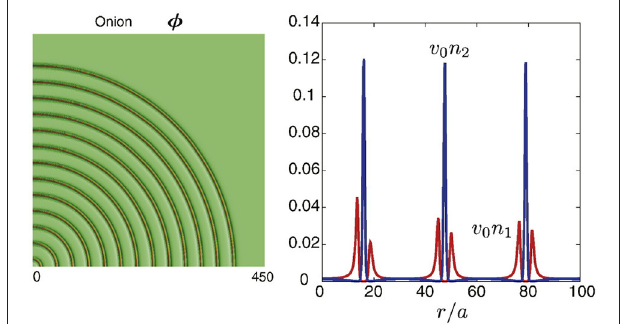
FIGURE 5 | Numerically calculated multilamellar vesicle and charge density in water/organic solvent/antagonistic salt (hydrophilic cation and hydrophobic anion pairs) mixture. φ denotes the volume fraction of water, n 1 the number density of cations, and n 2 the number density of anions. v 0 = a 3 is the molecular volume of solvent. r represents the distance from the center of the multilamellar vesicle. In the mixture, the average volume fraction of water in the mixture, < φ > , is set to 0.8. The figure on the left shows cross-sectional profile of φ , while the figure on the right shows the charge density around three membranes. The figure is reproduced from Onuki et al. [13] with permission from Copyright 2016 Elsevier